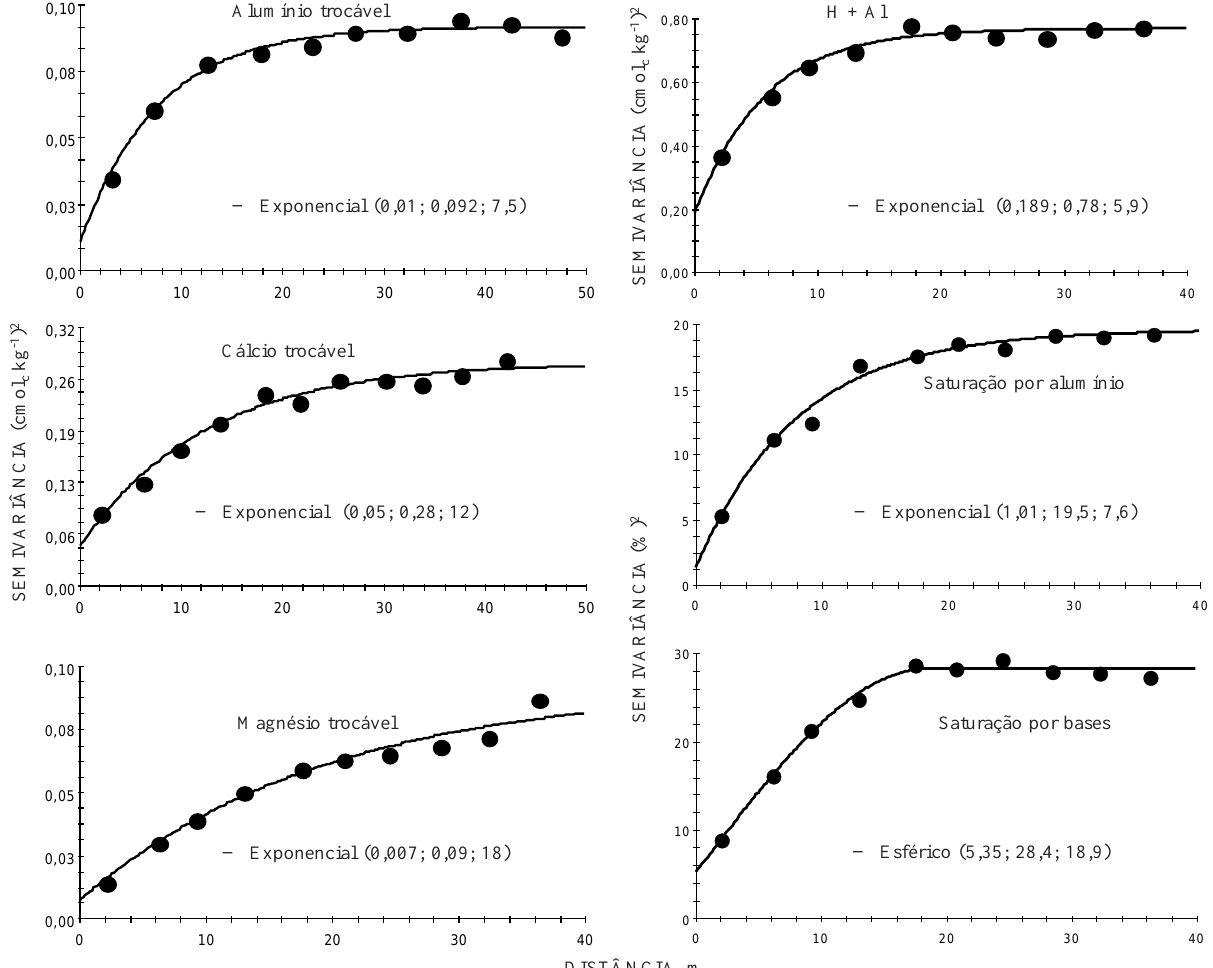
Figura 3. Semivariogramas das variáveis alumínio trocável, cálcio trocável, magnésio trocável, H + Al, saturação por alumínio e saturação por bases. (Valores entre parênteses são, respectivamente, efeito pepita, patamar e